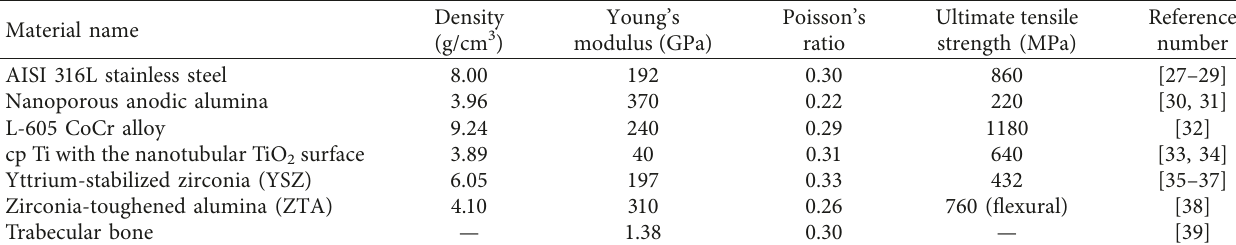
Table 1: The properties of materials used in this